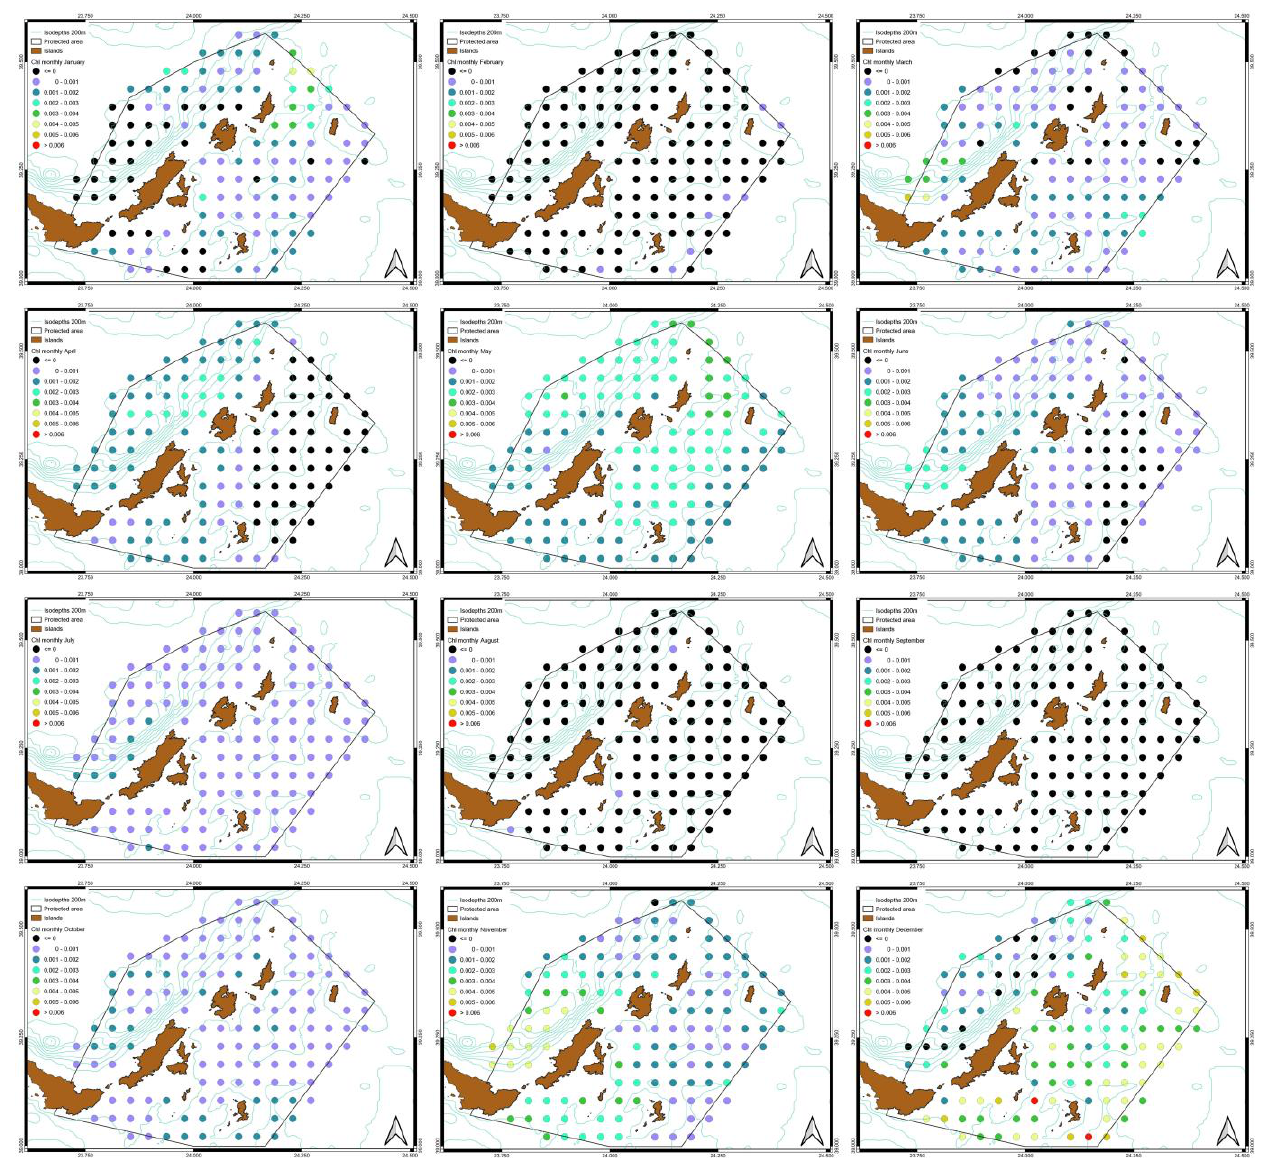
Figure 10. Monthly Chl-a slope distribution. Generally, there is an increase apart from August, September and February where there is a decrease.